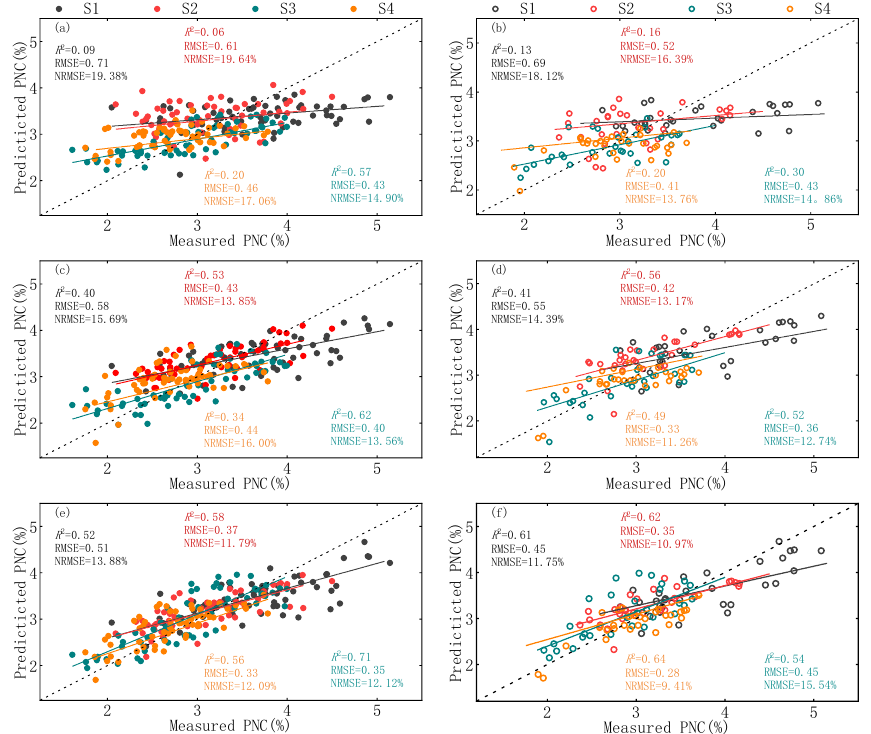
Figure 8. Predicted versus measured PNC. Predicted PNC was estimated by models constructed from the three optimal spectral indices to estimate the effect of potato PNC in different growth periods. ( a , c , e ) modeling dataset; ( b , d , f ) validation dataset.